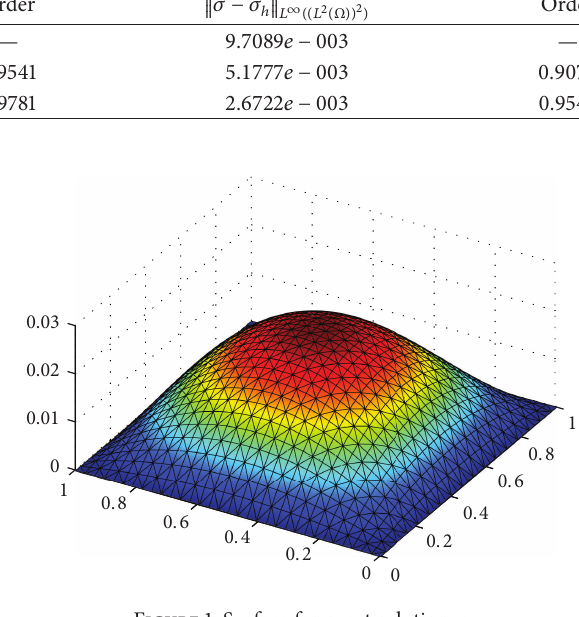
Figure 1: Surface for exact solution 𝑢 .